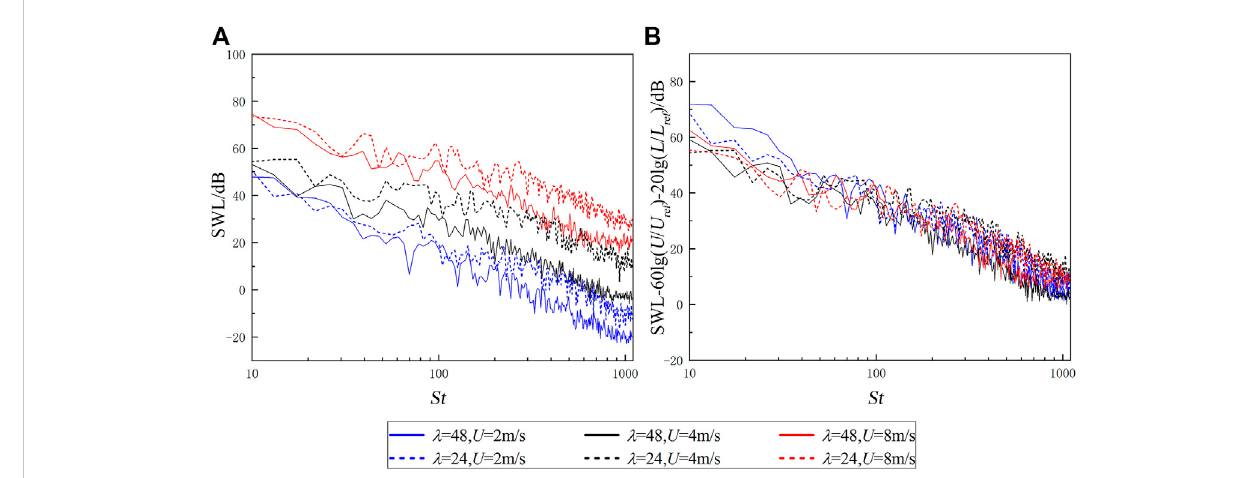
FIGURE 12 Radiated SWL of (A) calculated results and (B) normalized results under different conditions.